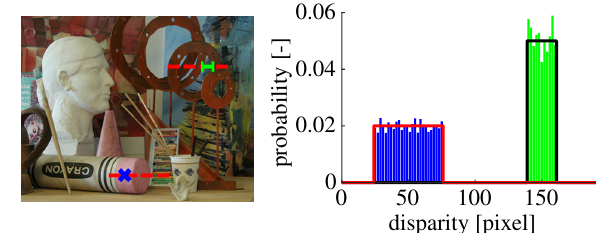
Figure 1. Illustration of the underlying assumptions of the proposed geometry-aware model. On the left, the right image of a stereo pair with a correct point match in a texture-less region and matching area in an occlued region are shown in blue and green, respectively. The considered search space is highlighted in red. On the right, the corresponding probability distributions over the considered disparity range are shown. The histograms of the two cases, shown in blue and green, are approximated by Uniform distributions, shown in red and